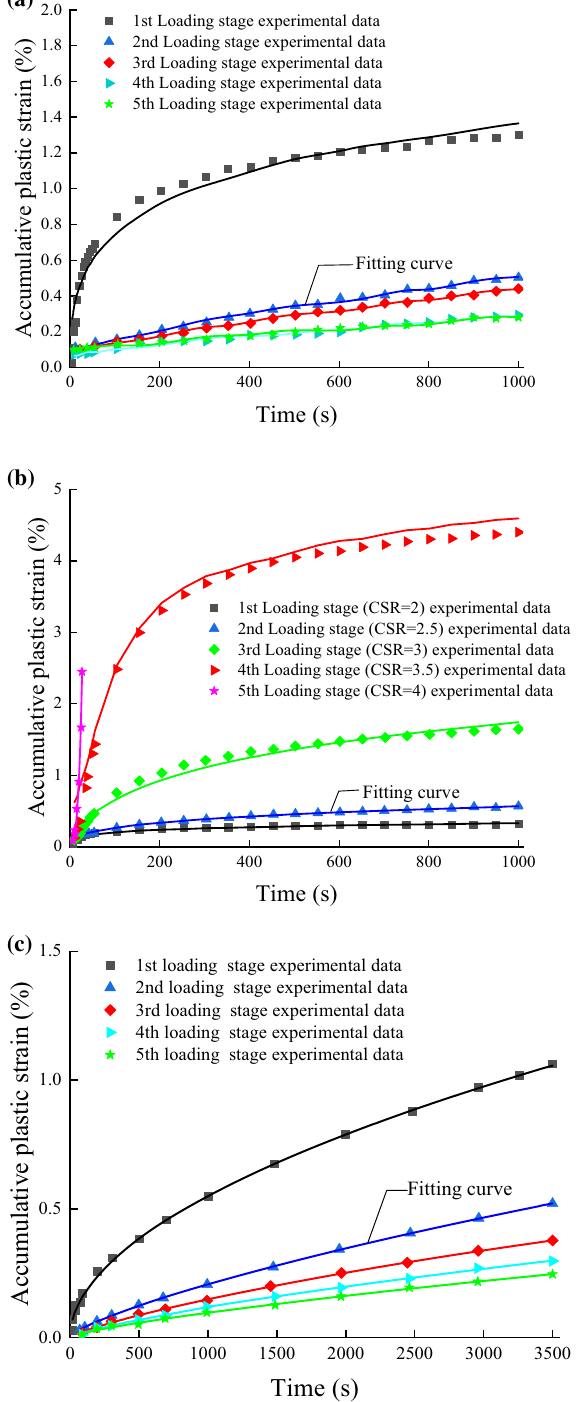
Figure 12. ( a ) Comparison between experimental data and model fitting curve of fine-grained soil under single-stage intermittent cyclic loading ( w opt = 11.8 %, σ 3 = 60 kPa, CSR = 2). ( b ) Comparison between experimental data and model fitting curve of fine-grained soil under multi-stage intermittent cyclic loading ( w opt = 11.8% , σ 3 = 60 kPa, CSR = 2–2.5–3–3.5–4). ( c ) Comparison between experimental data and model fitting curve of saturated soft clay under single-stage intermittent cyclic loading ( σ 3 = 100 kPa, CSR =